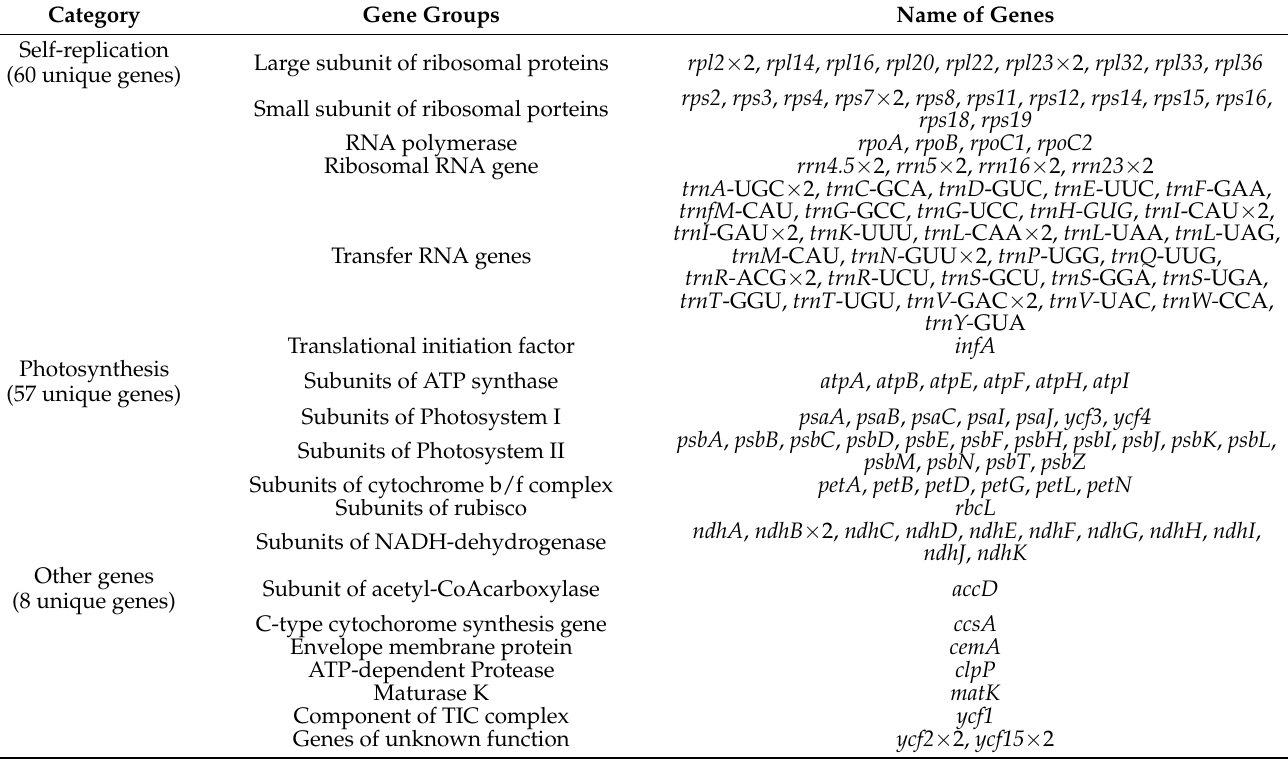
Table 2. List of genes encoded by the chloroplast genome of Cardamine hupingshanensis